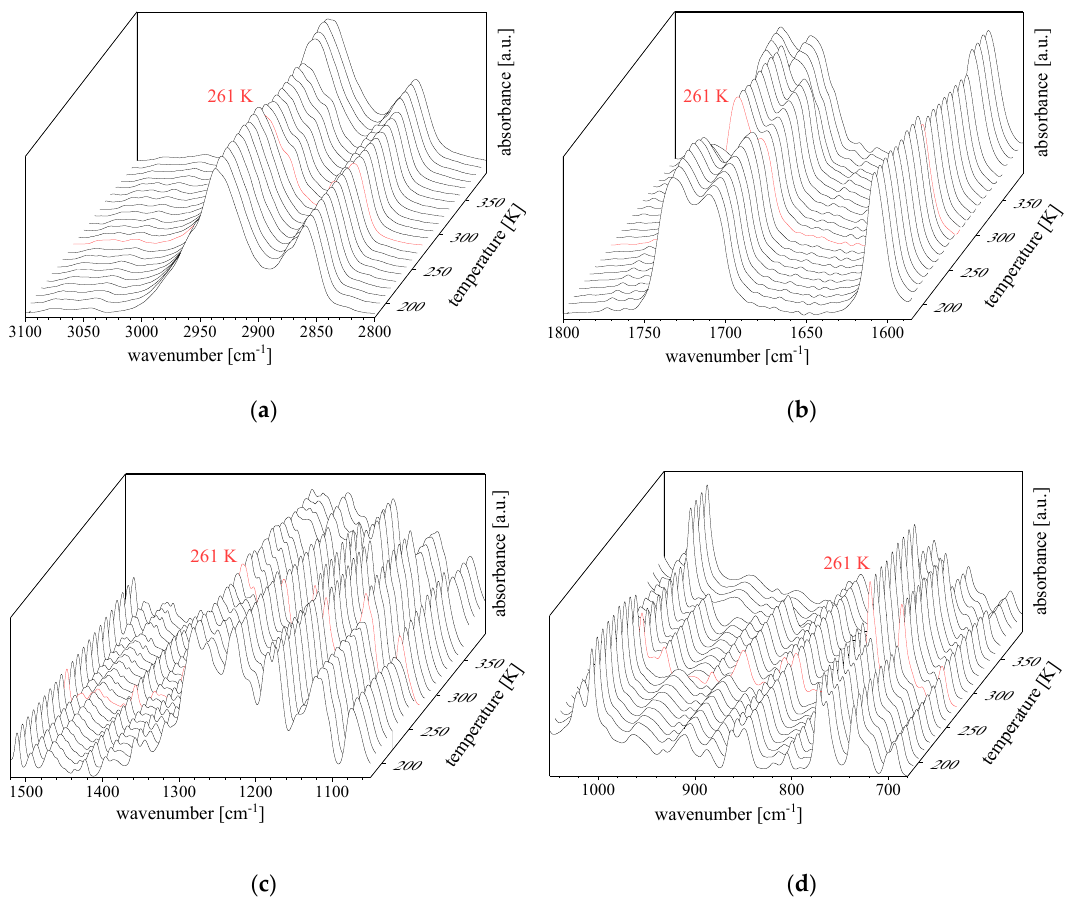
Figure 8. The FTIR spectra of 3F7HPhH7 upon heating at a rate of 2 K/min (after fast cooling) from 173 to 403 K in the wavenumber regions of: ( a ) 3100–2800 cm –1 , ( b ) 1800–1580 cm –1 , ( c ) 1520–1050 cm –1 and ( d ) 1050–680 cm –1 .